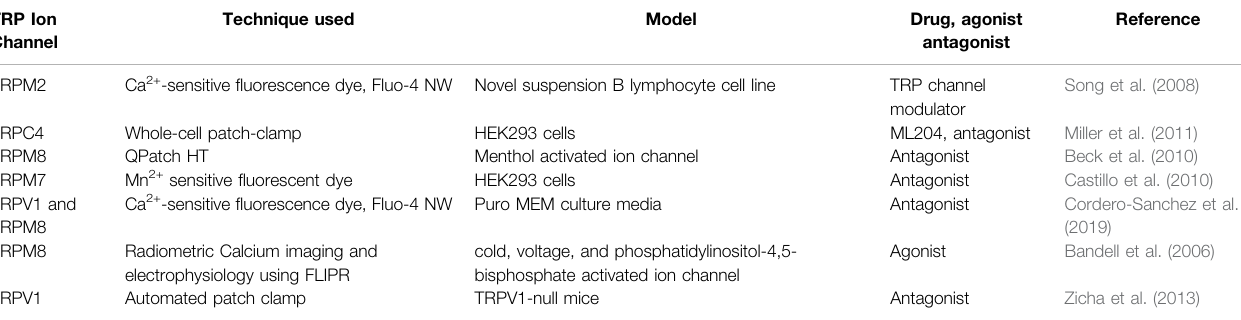
TABLE 3 | A list of studies reporting the TRP ion channel drug discovery using techniques other than Ion Channel Reader (ICR)